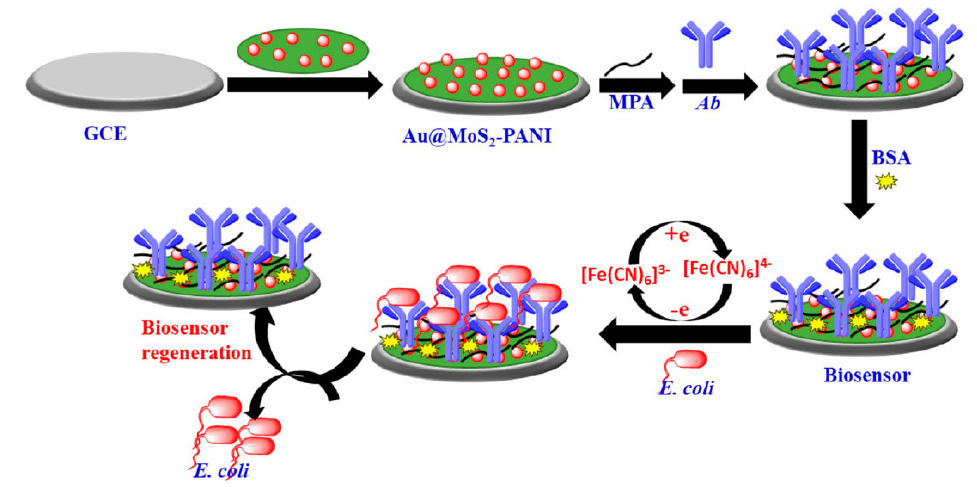
Figure 4. Schematic diagram of electrochemical biosensor for E. coli (Reprinted with permission from Ref. [18]. 2021, Raj et al.).